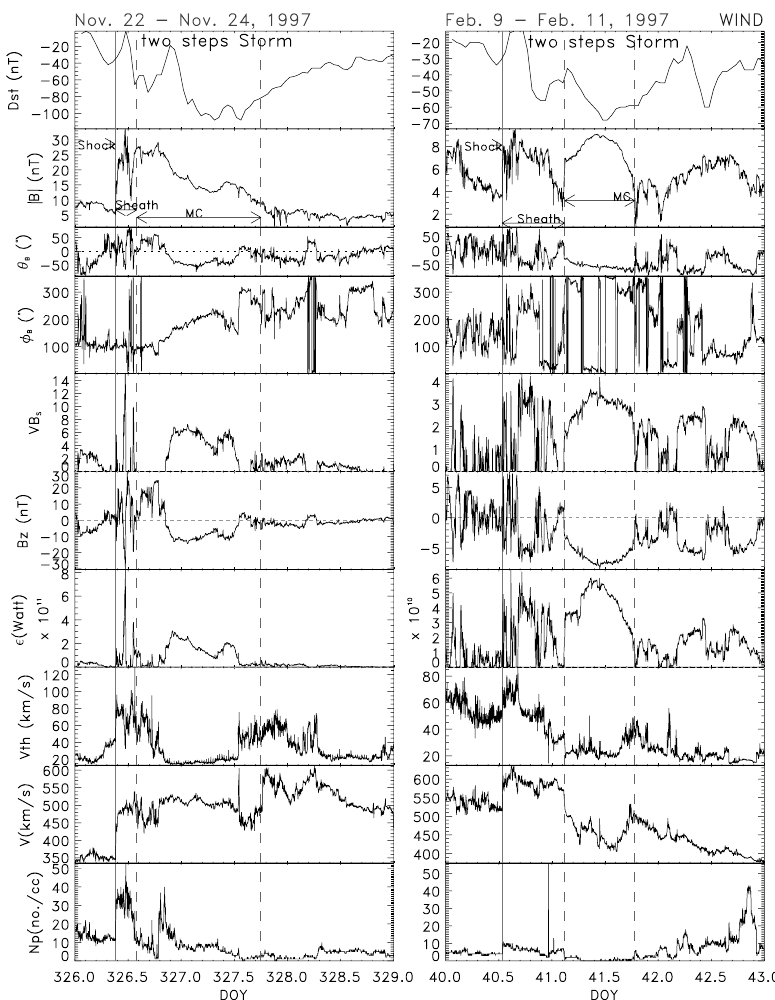
Fig. 1. Solar wind parameters and Dst for two magnetic clouds: 22–24 November 1997 and 9–11 February 1997. The parameters are (from top to bottom): geomagnetic index ( D st ), interplanetary magnetic field magnitude ( | B | ), field latitude ( θ B ), and longitude ( φ B ), induced electric field ( V B s ), north-south component of the IMF ( B z ), Akasofu (1981) (cid:15) , proton thermal speed ( V th ) , plasma bulk speed ( V ), proton density ( N P